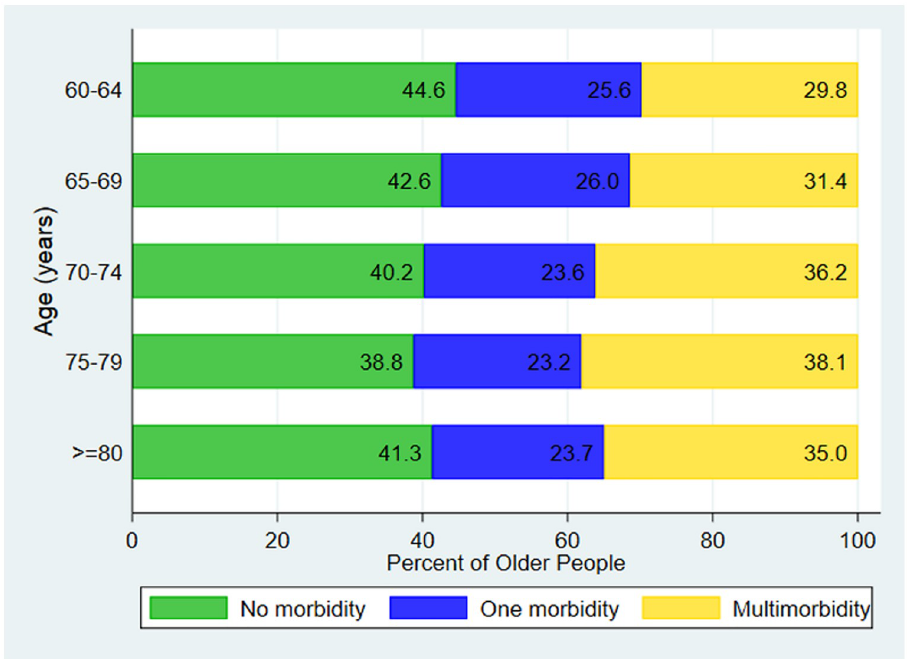
Fig 1. Morbidity patterns of older people by age group (n = 4859).